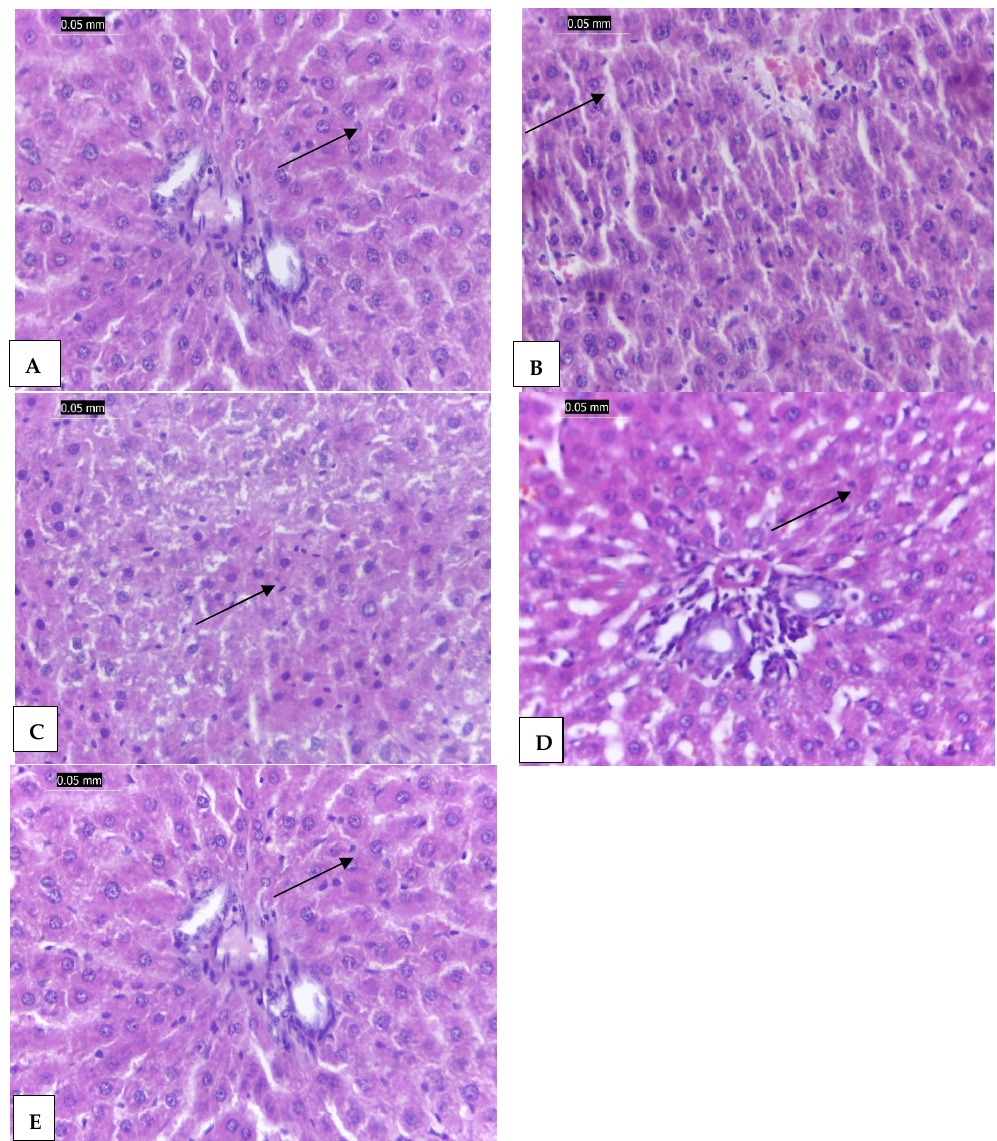
Figure 7. ( A ): The control negative group (G1) showing normal hepatic tissues architecture without any necrosis or inflammation (arrow), ( B ): The CCl 4 treated group (G2) showing distorted hepatic plates, fatty hepatocytes (arrow), and dense portal tract mononuclear infiltrate, ( C ): G3 treated with vanillic acid showing mild inflammation (arrow), ( D ): The G4 group treated with vanillic AgNPs showing mild inflammation to nearly normal hepatic tissues (arrow), and ( E ): The silymarin treated group (G5) showing nearly normal hepatic tissues (arrow). (H & E × 400).